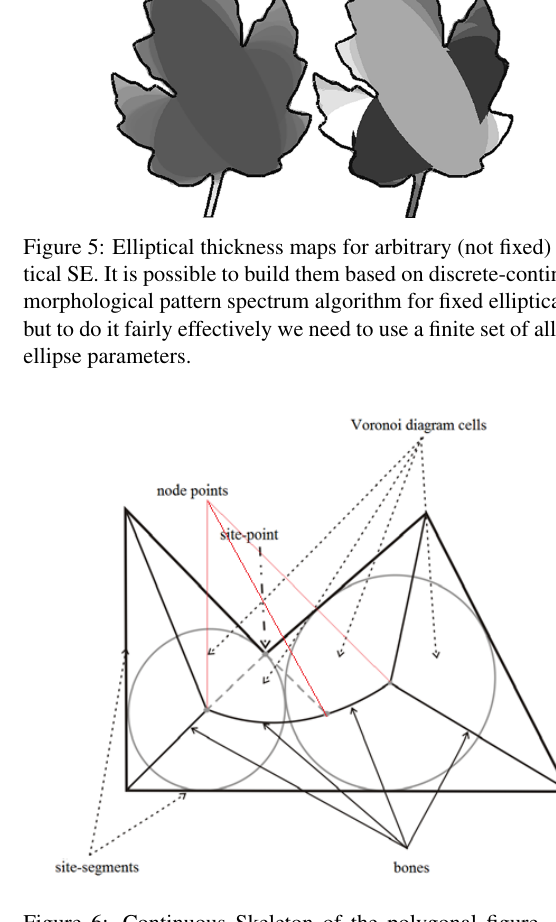
Figure 6: Continuous Skeleton of the polygonal figure. Site- points, site-segments, node-points are